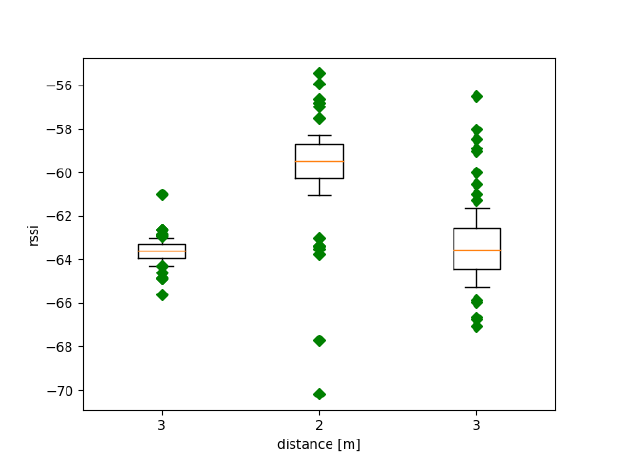
Figure 10. The box plot showing the readings from three phases of the study corresponding to different distances between the devices, 3m, 2m and 3m consecutively after application of the data smoothing procedure.